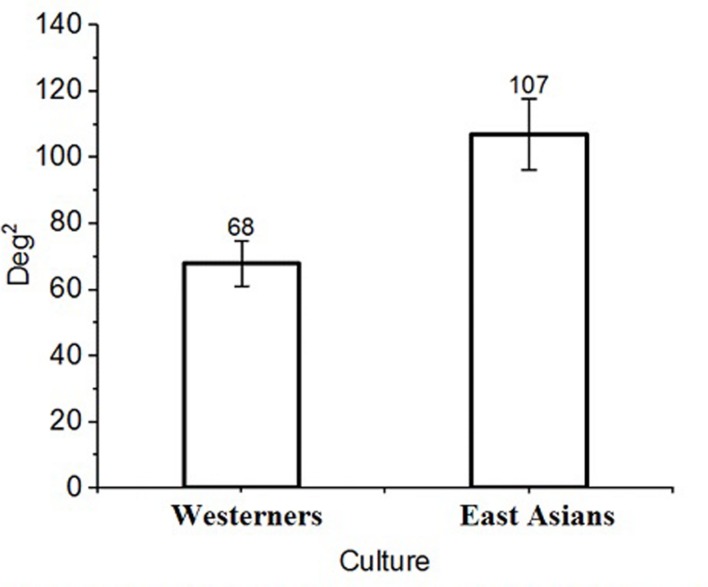
Bivariate Contour Ellipse Area (BCEA) comparisons. East Asians had a wider spread of fixation points than Westerners. Error bars represent ±1 SEM.